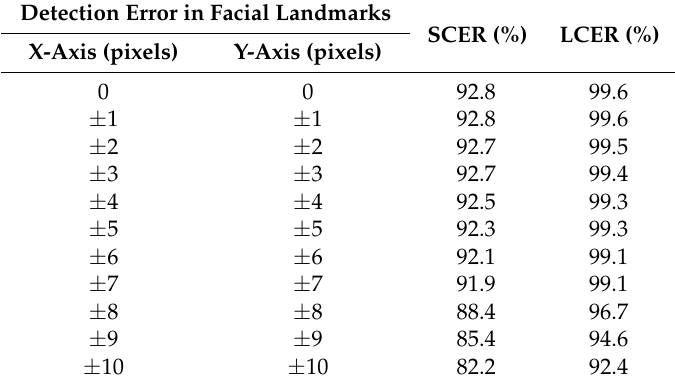
Table 14. SCER and LCER of our method according to the errors in facial landmark detection by Dlib facial feature tracker (X-axis of 0 and Y-axis of 0 mean no detection error in facial landmarks). Detection Error in Facial